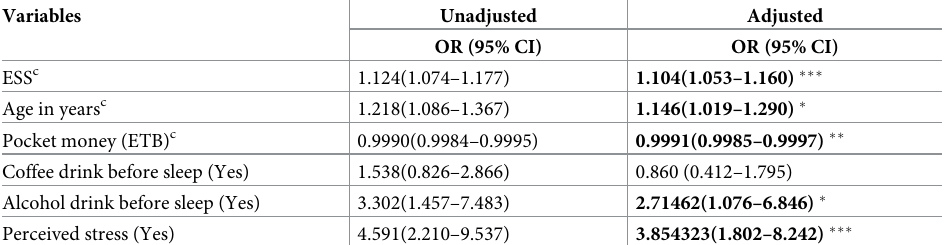
Table 2. The determinants of DEB using binary logistic regression model among medical students at the Univer- sity of Gondar, Northwest Ethiopia, 2021 (N =